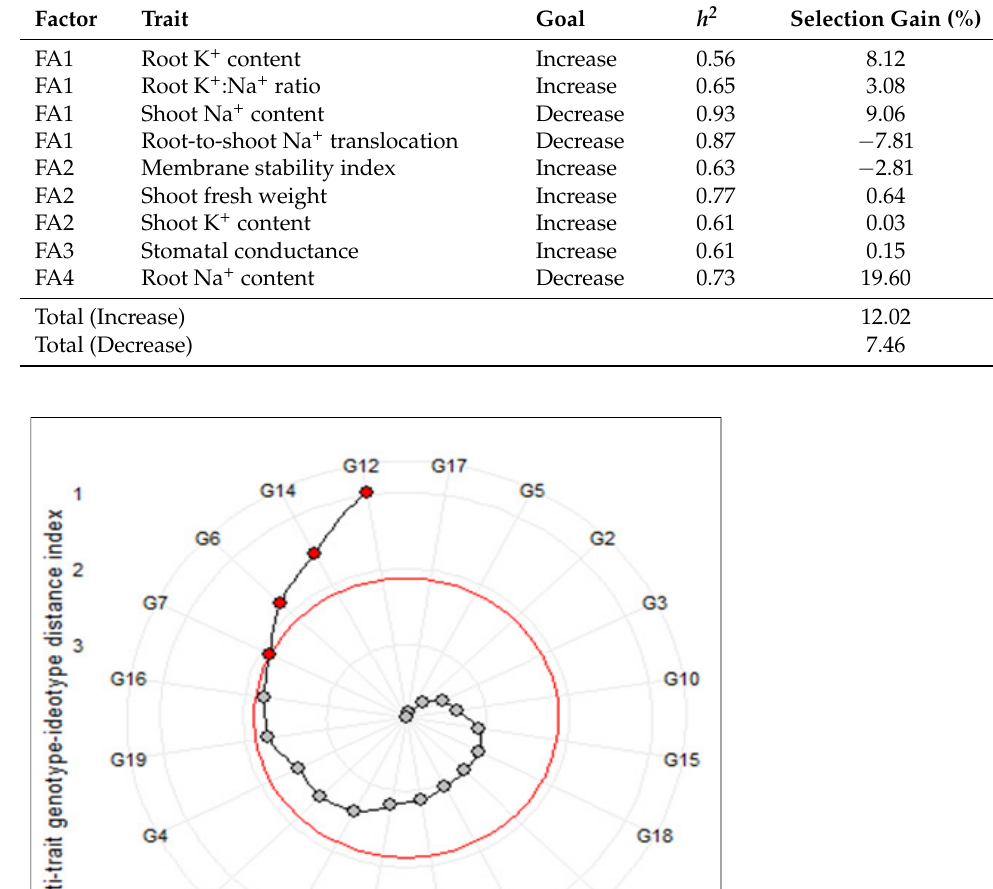
Table 4. Predicted genetic gain for the effective traits in the MGIDI index under salinity stress conditions.